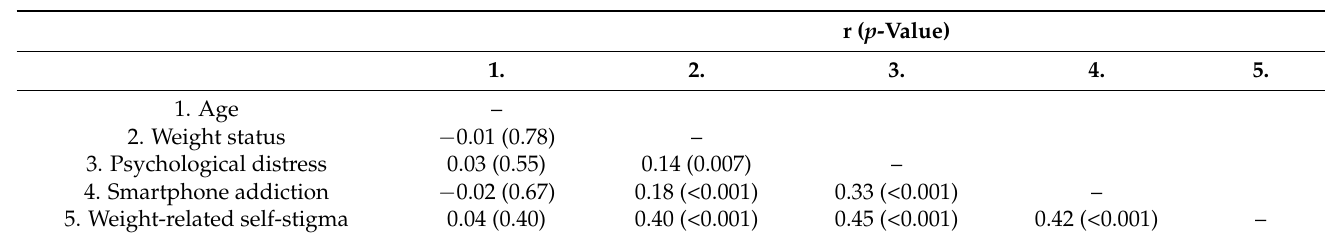
Table 2. Zero-order bivariate correlation coefficients between studied variables in female univer- sity